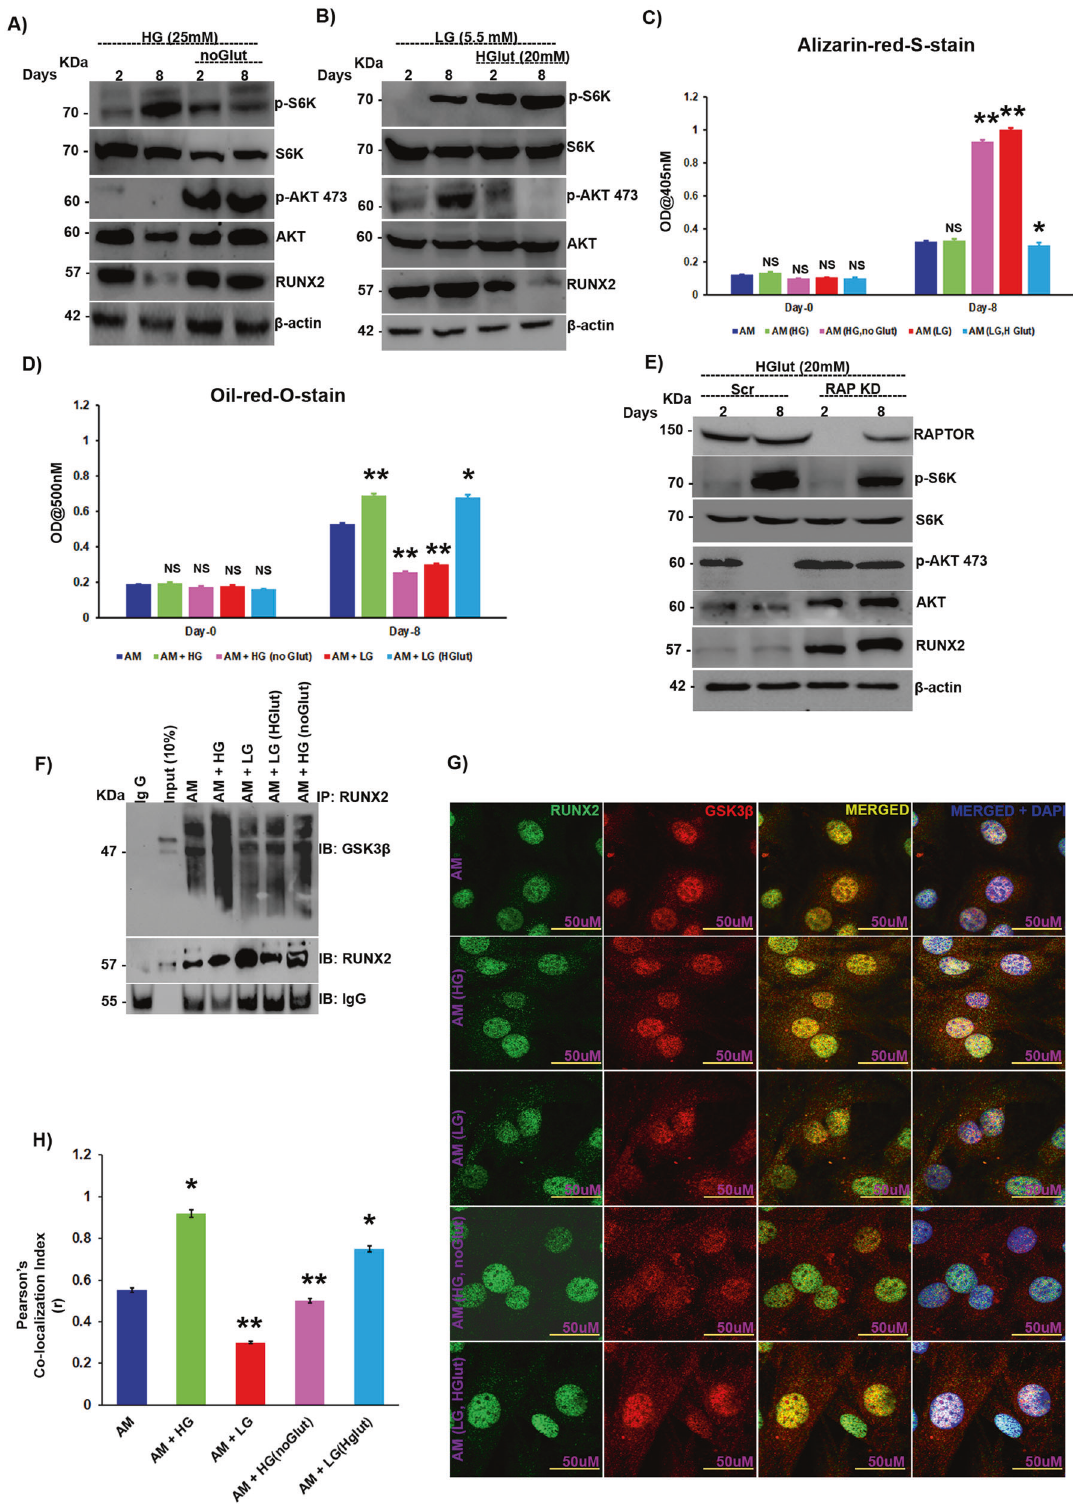
the activation of AKT, which inhibits GSK3 β , due to which RUNX2 was rescued from ubiquitination. Metformin, by activating AMPK and inhibiting GSK3 β , could modulate the intracellular levels of glutamine through GLS. Taken together, our data indicate that RUNX2 is stabilized directly by the mTORC2/AKT-473 axis by inhibiting GSK3 β . Under Cell Death Discovery (2022)